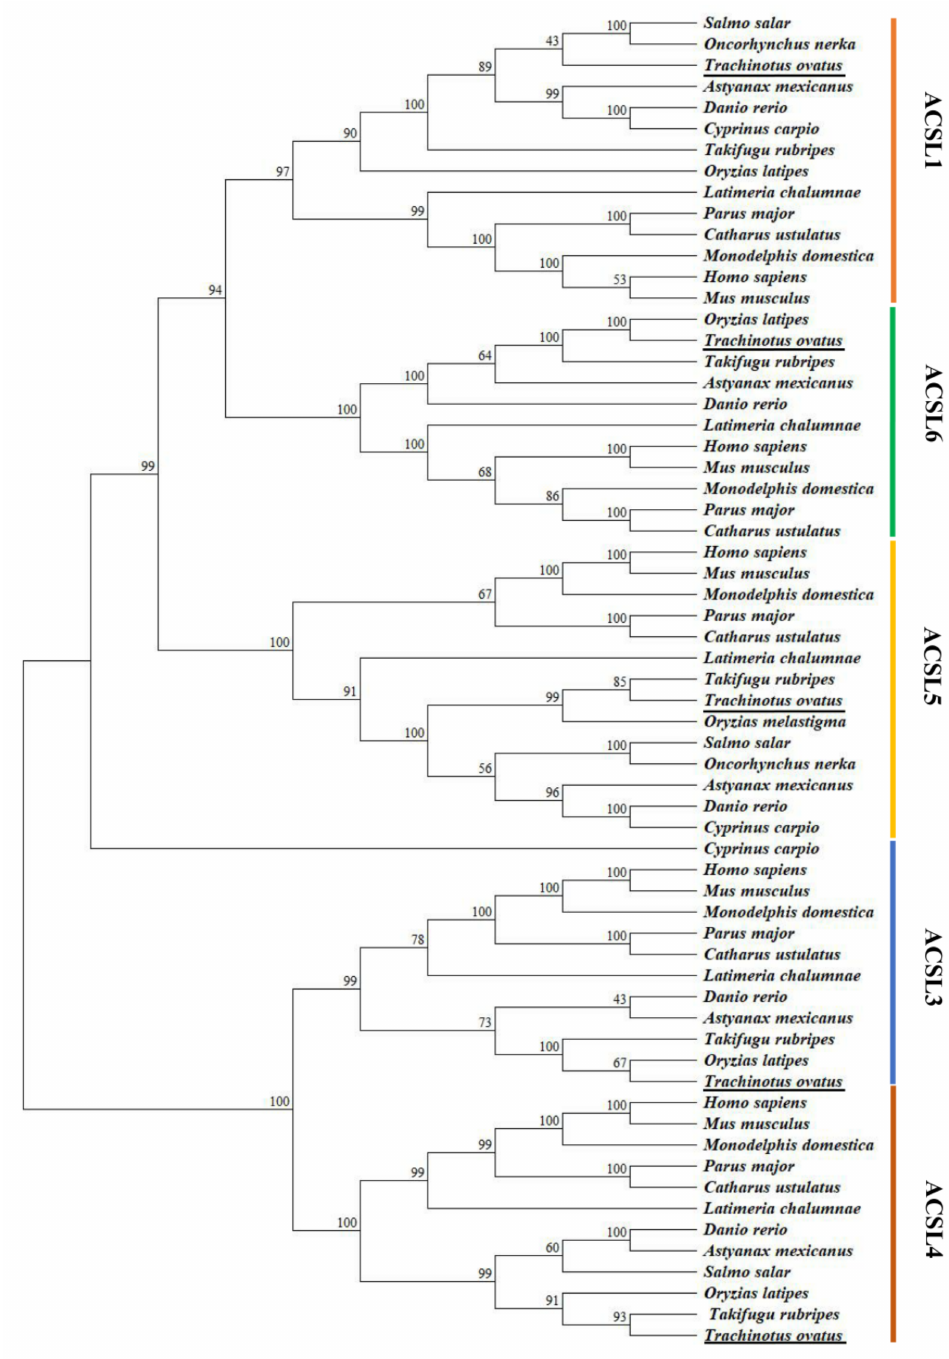
Figure 1. Phylogenetic analysis of the Trachinotus ovatus acsl family from different animal species. The phylogenetic tree was generated based on an alignment corresponding to the amino acid sequences using ClustalW and MEGA (11.0). The number at nodes represent percentage bootstrap values (only values above 40% are shown) on 1000